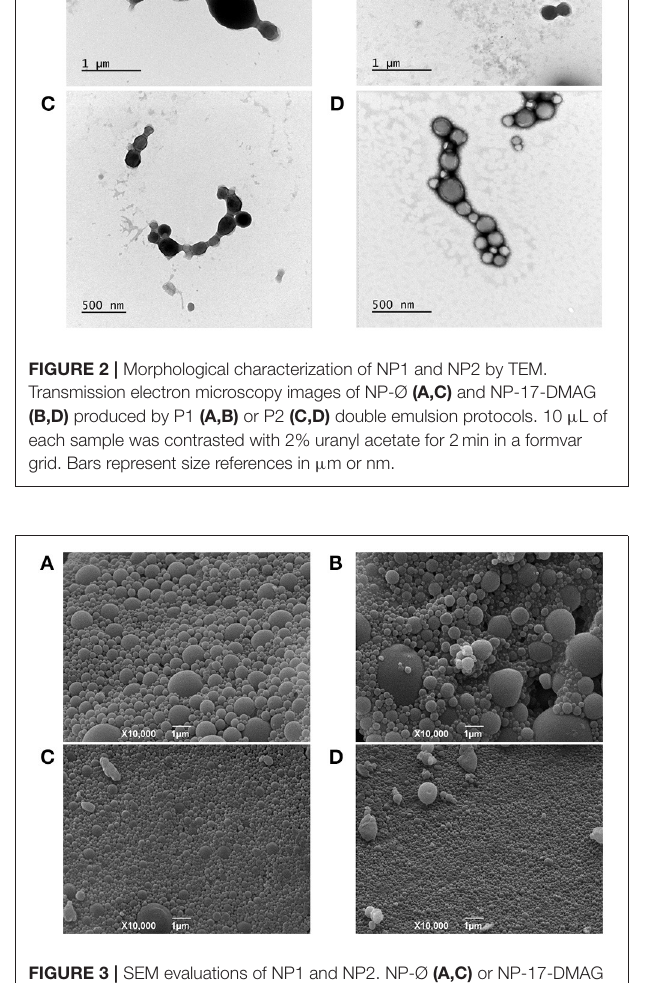
FIGURE 3 | SEM evaluations of NP1 and NP2. NP-Ø (A,C) or NP-17-DMAG (B,D) were produced by P1 (A,B) or P2 (C,D) double emulsion protocols. The produced NPs were frozen at − 80 ◦ C and lyophilized for 24h at − 48 ◦ C under 0.050 mbar. Approximately 1mg of each sample was vacuum-coated with gold-palladium using an ion coater and analyzed by SEM. All samples were analyzed and photographed at 15 kV. Bars represent 1 µ m.